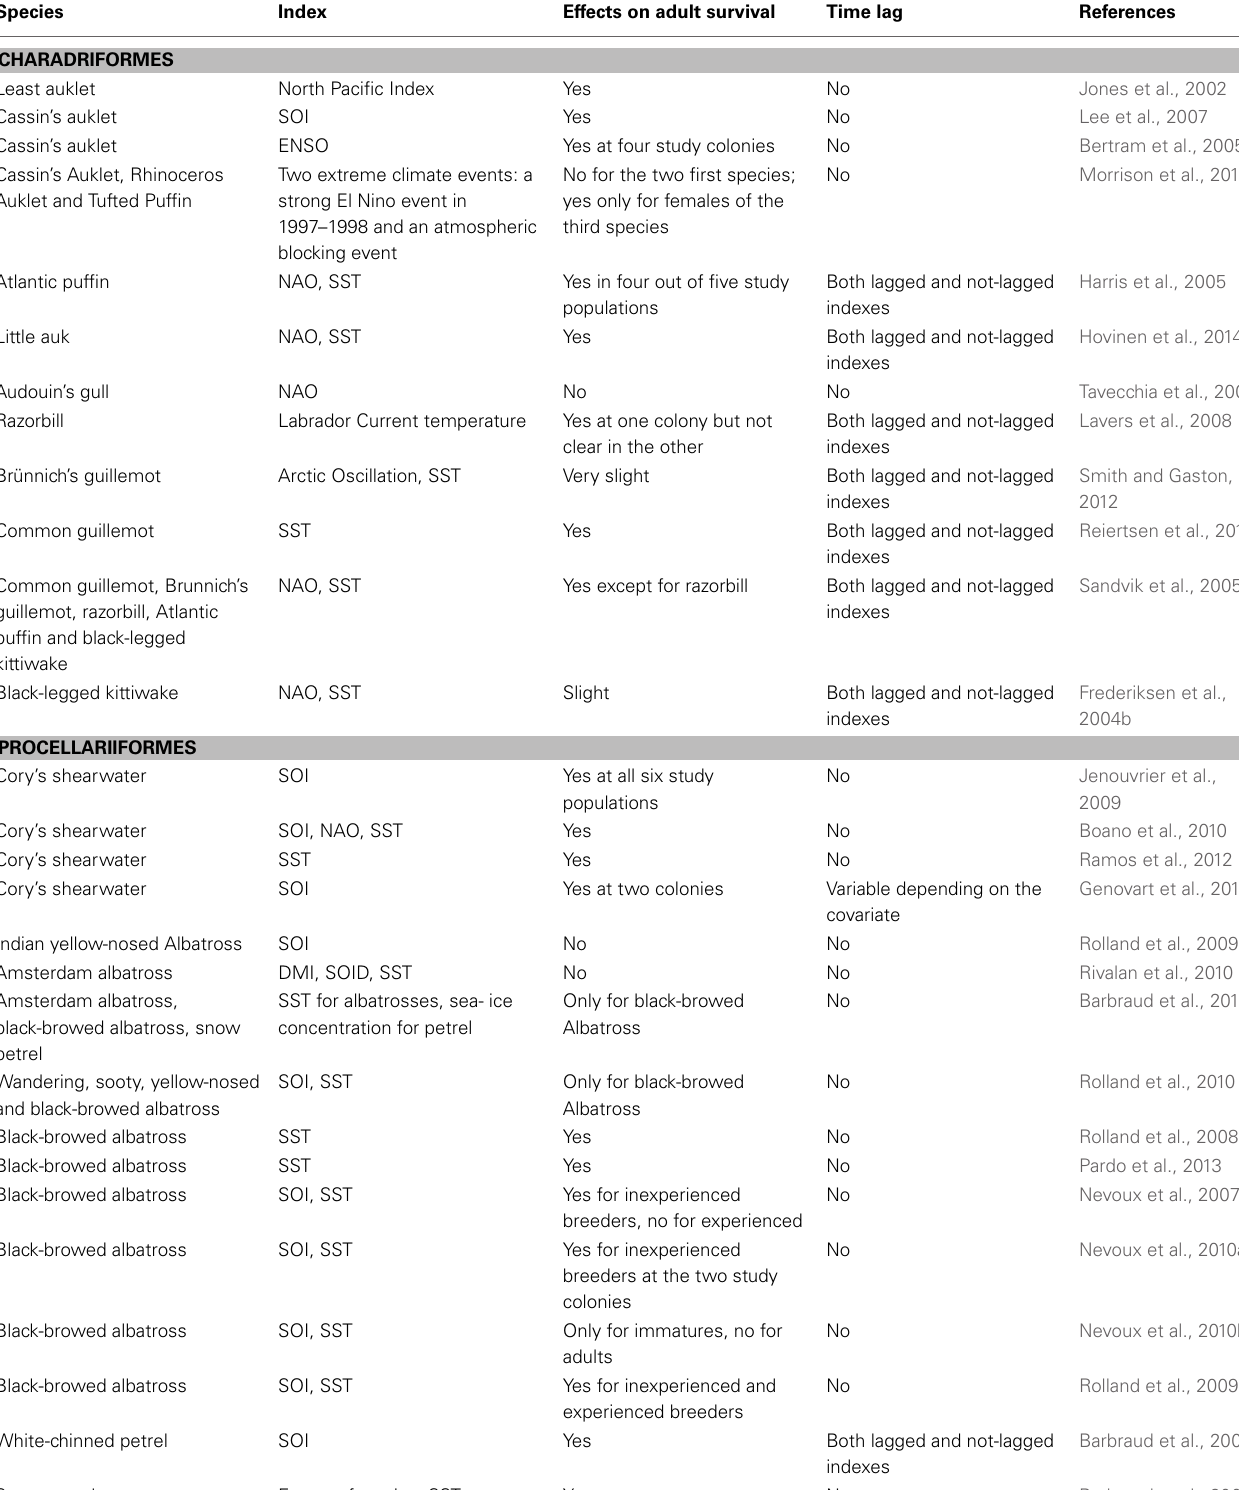
Table 1 | Studies assessing the effects of climate on seabird adult